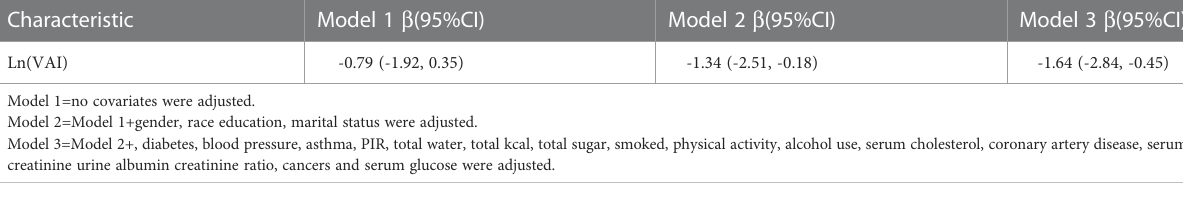
TABLE 4 Analysis between VAI with stroke age